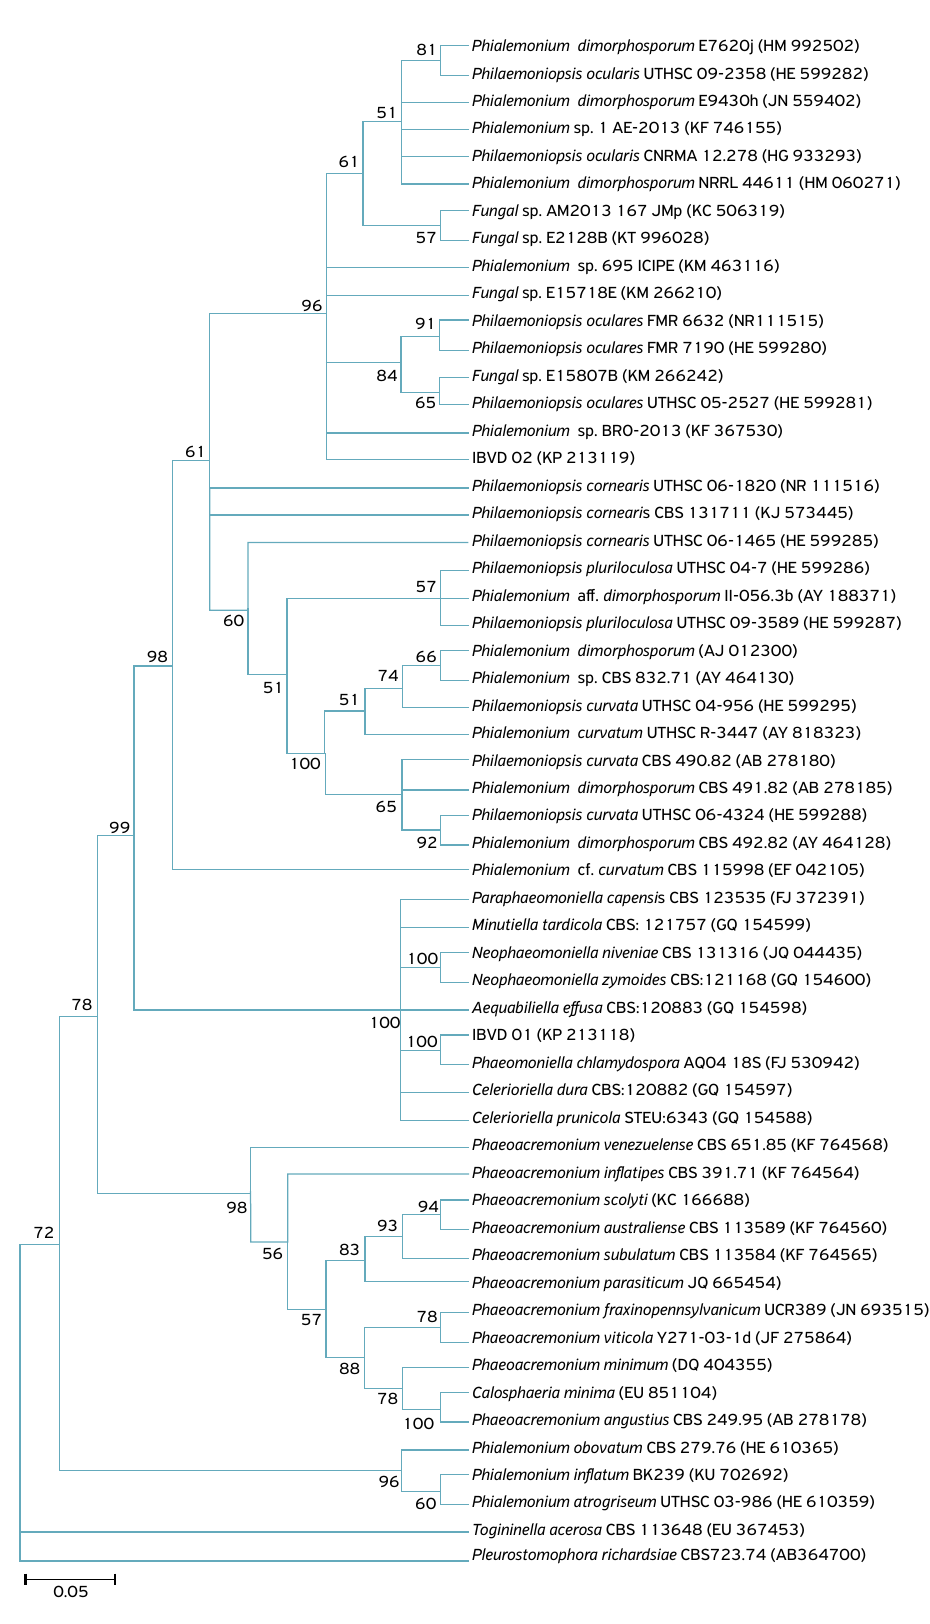
Figure 1. Phylogenetic trees showing the relationship between the isolates of fungi detected in ‘Niagara Rosada’ vine in comparison with the genera and species of fungi isolated from vines and deposited in GenBank-NCBI. The trees were constructed on the basis of the following sequences: (A) ITS-5.8S region – showing condensed tree with 50% cut-off value; and (B and C) parts of the beta tubulin gene. The isolates Pleurostoma richardsiae (= Pleurostomophora richardsiae ) and Conioachaeta lignicola (= Lecythophora lignicola ) were used as the outgroup. The accession number of the sequences of the isolates in GenBank-NCBI is given